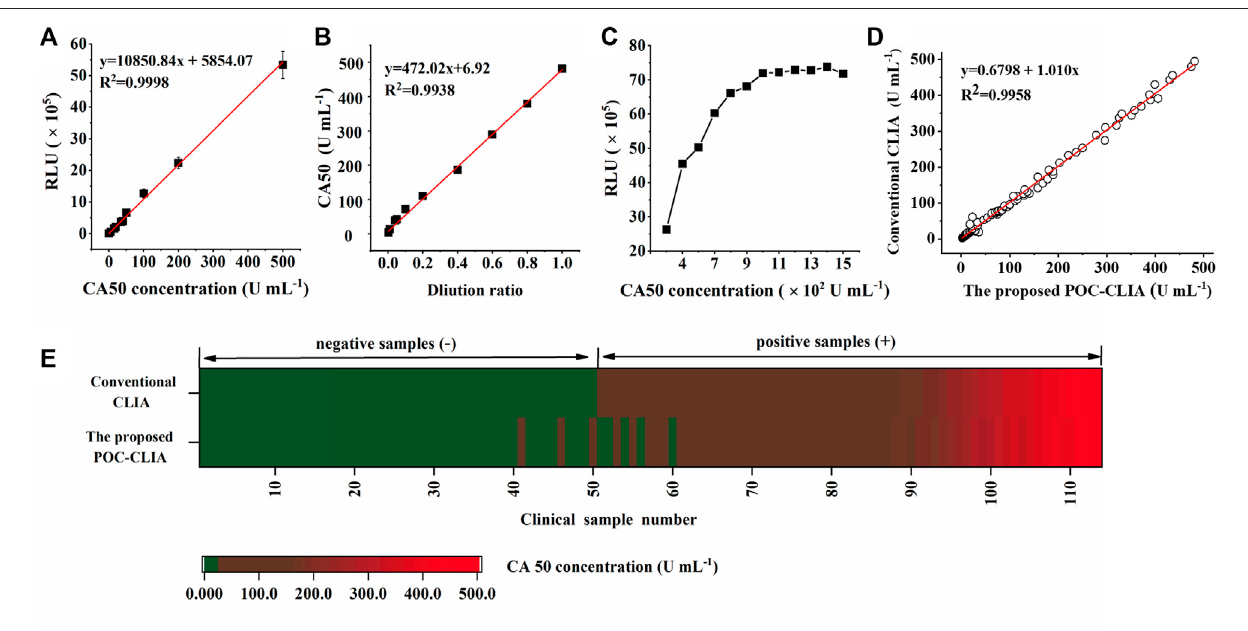
FIGURE 4 | Evaluation of the performance of the miniaturized CLIA analyzer for CA50 detection: standard calibration curve (A) ; linearity-dilution effect (B) ; hook effect (C) ; and clinical performance (D,E) . The color green represents the negative sample containing CA50 below 25 U ml − 1 , and red means the positive sample containing CA50 over 25 U ml − 1 ,